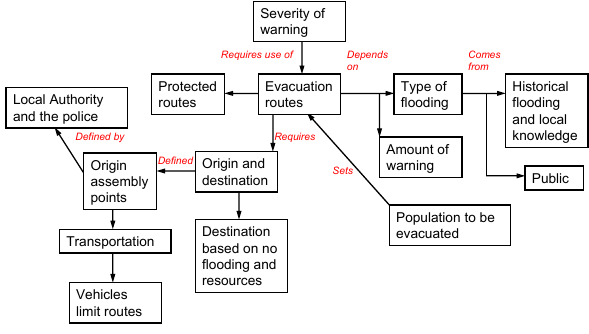
Fig. 2. An example of a generic entity diagram.